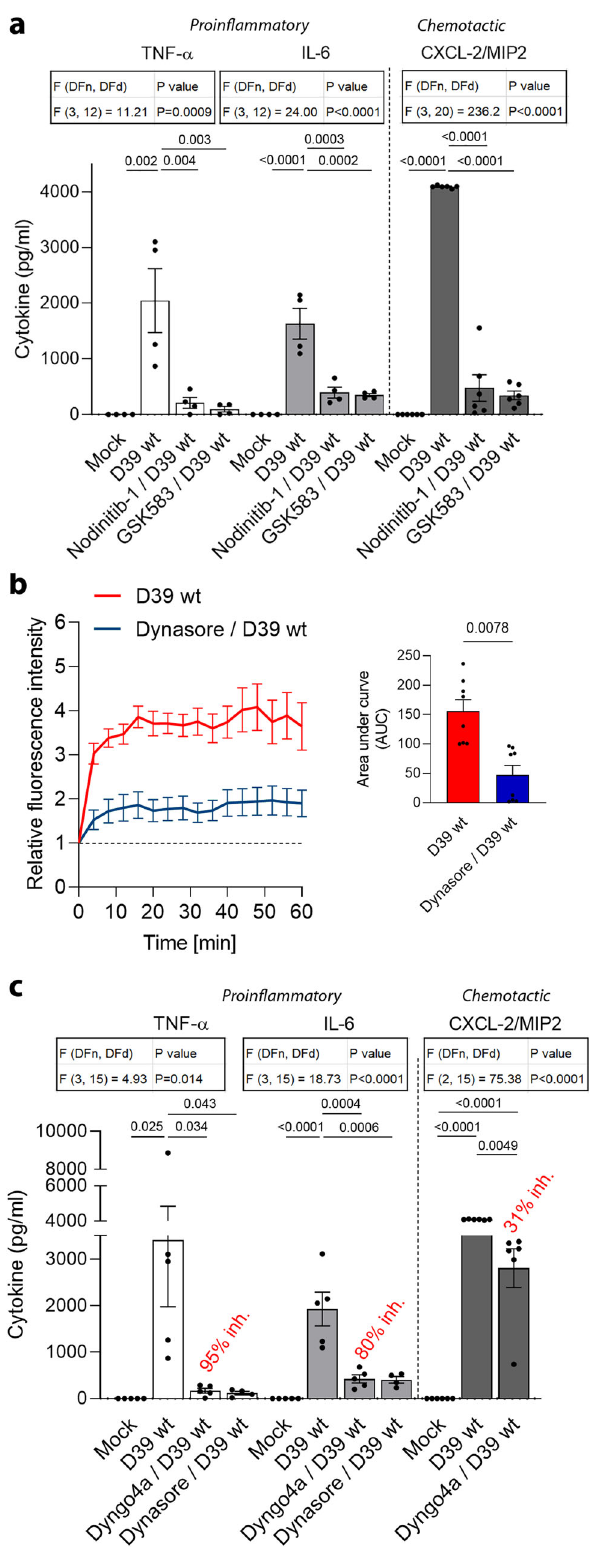
or a domain 4 form of the toxin (the membrane-binding nonpore- forming domain of PLY) failed to enhance endocytosis (Fig. 3d).